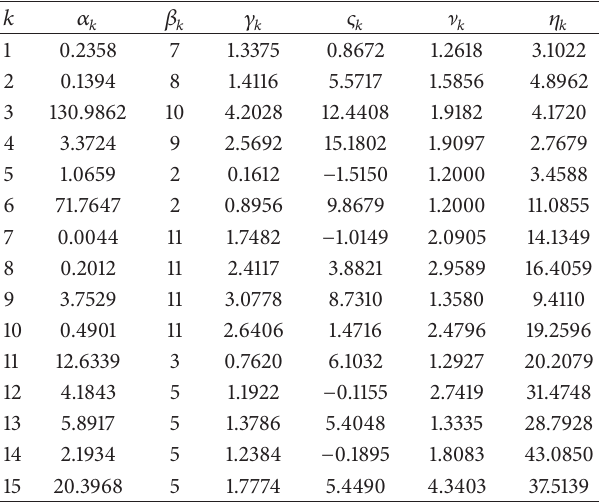
Table 2: Estimated parameters of the ground acceleration model for Orion Boulevard 1971 earthquake